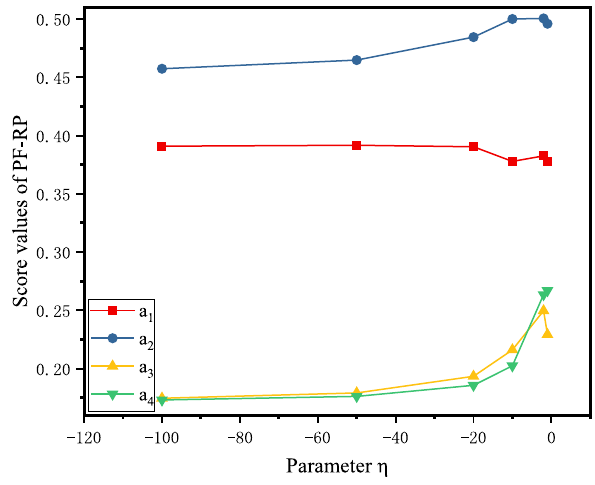
Fig. 5 Score values of the alternative using PF-RP for different